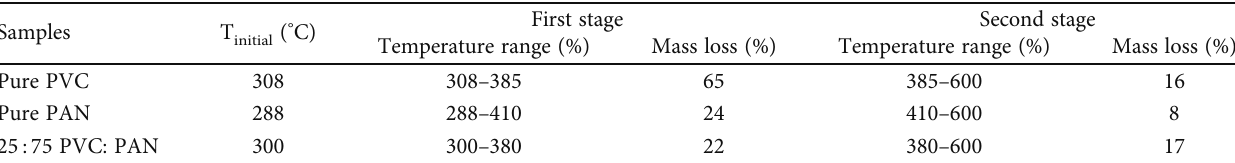
Table 5: Results of thermal properties of thermogravimetric analysis data under pure nitrogen for pure PVC, pure PAN, and 25 :75 PVC: PAN nano fi bers.